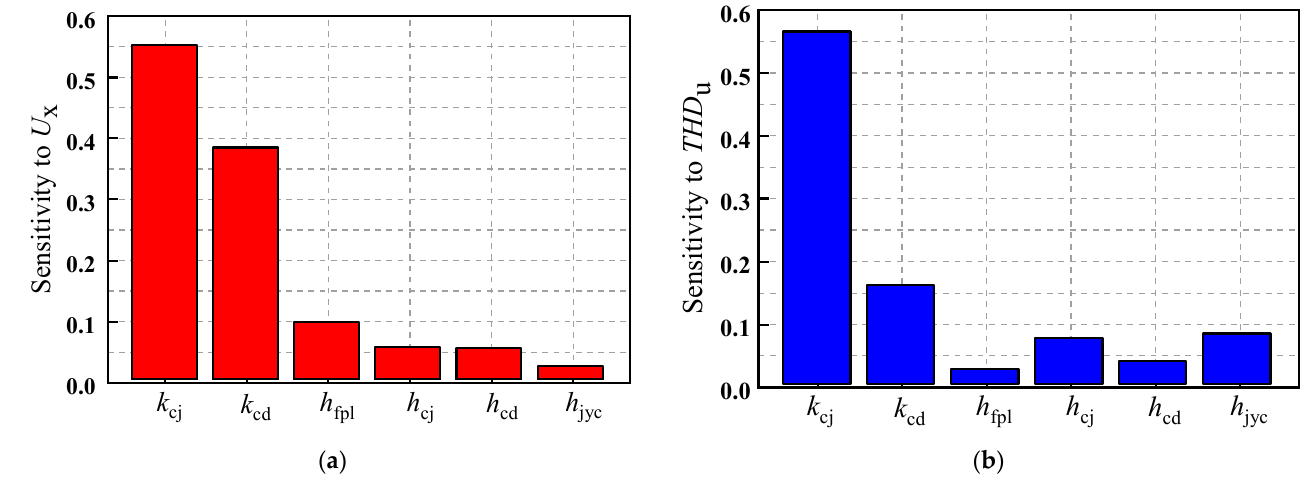
Figure 12. The sensitivity of optimization objective. ( a ) Sensitivity of each design variable to U x ; ( b ) sensitivity of each design variable to THD u .